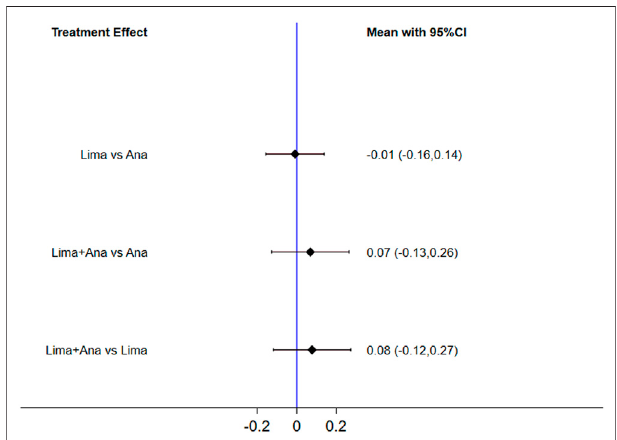
FIGURE 9 | Mean difference for EQ-5D between treatments.